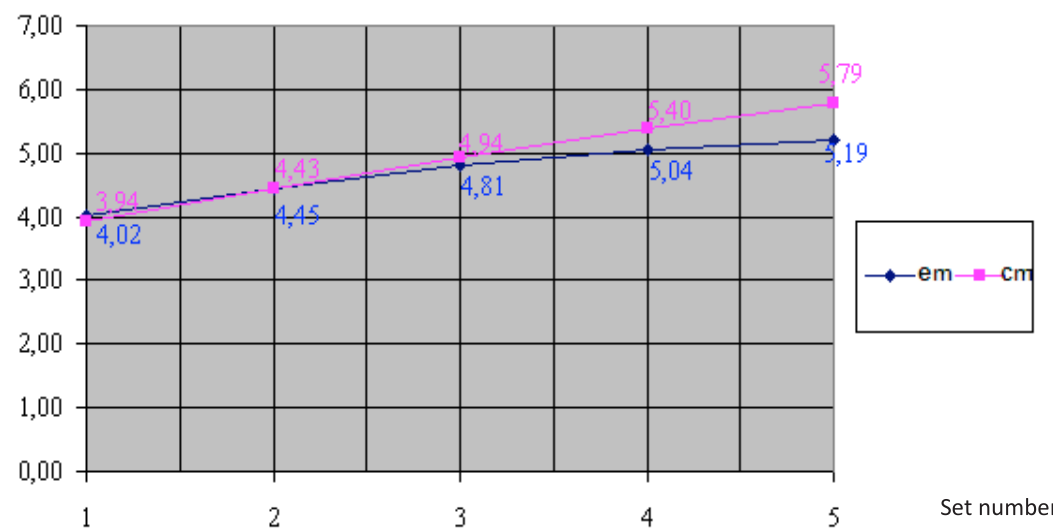
Fig. 4. Comparative analysis of experimental and control groups ping pong data for May, where е group data for May, c –control group data for May, 1 – 5 set numbers, 0 – 7.00 - quantity of made o